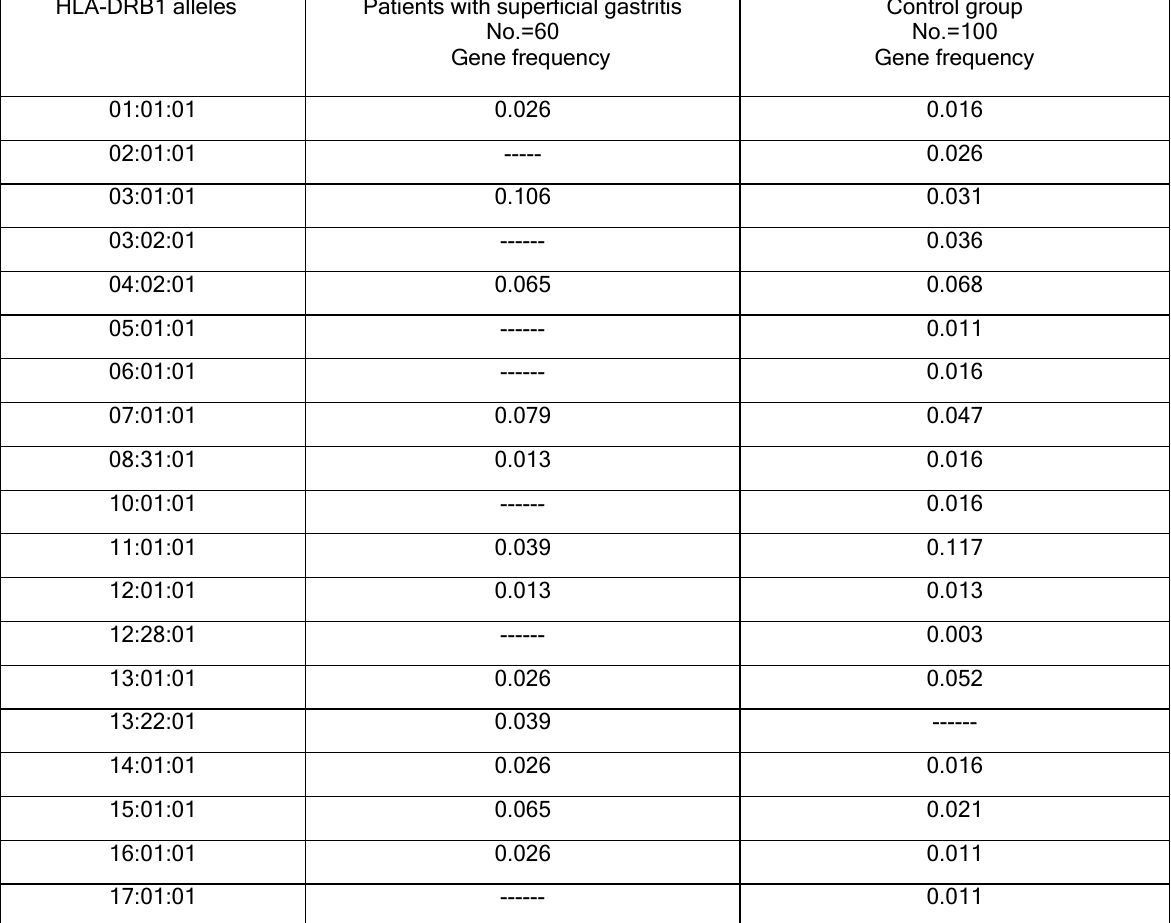
Table-5- Genotypes frequencies of HLA-DRB1 alleles in patients with superficial gastritis and control group. HLA-DRB1